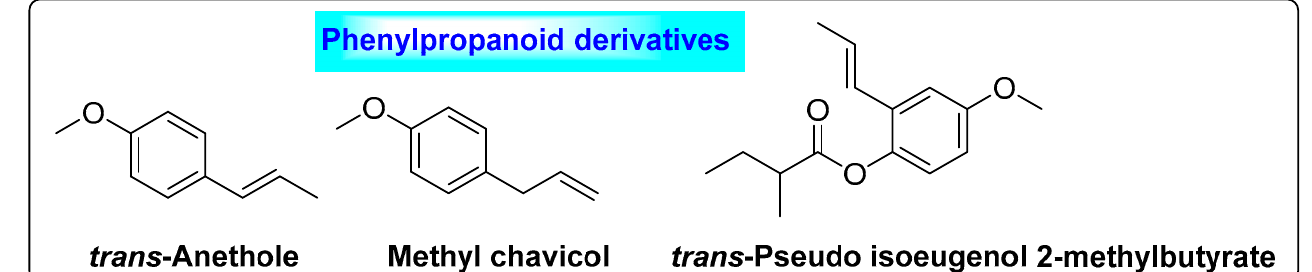
Figure 16. Phenylpropanoids present in Pimpinella anisum L. that possess anti-PCOS activity.